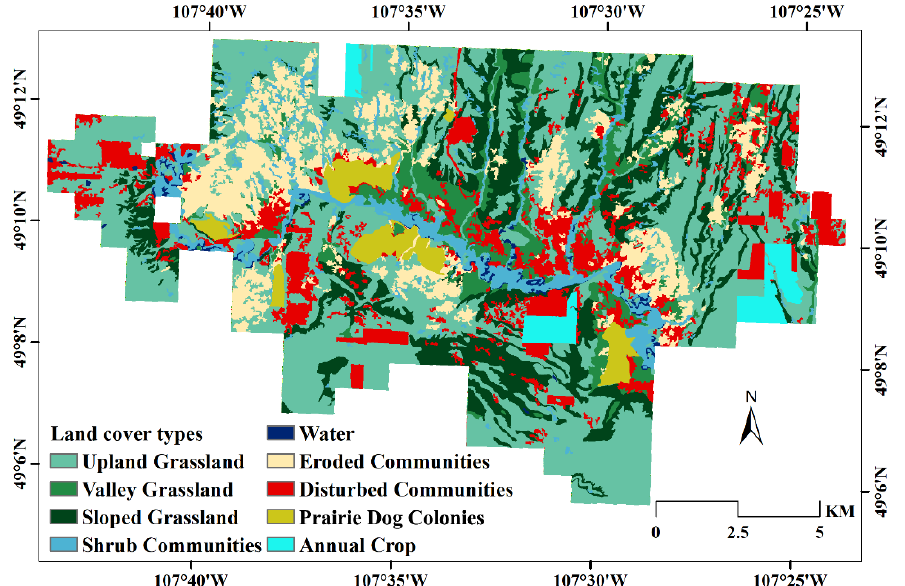
Figure 2. Vegetation communities in the west block of Grasslands National Park, Saskatchewan, Canada. This map was classified by the method described in Section 3.2.1.